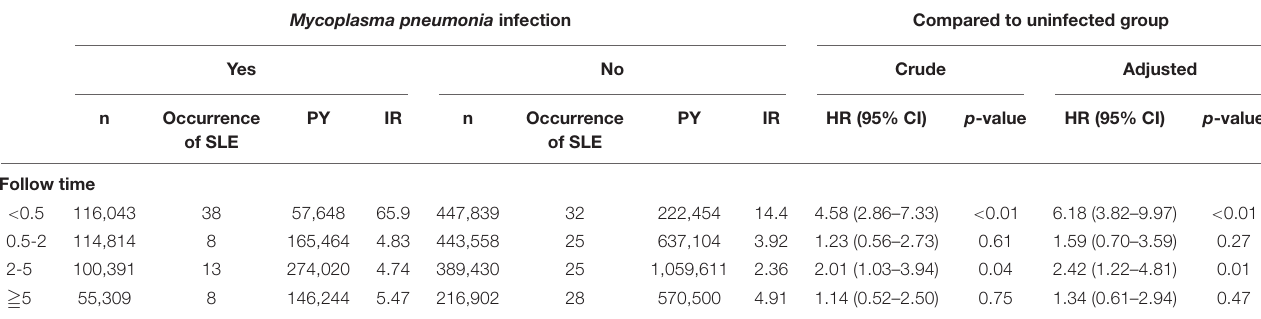
TABLE 3 | Incidence and hazard ratio of systemic lupus erythematosus according to the duration of